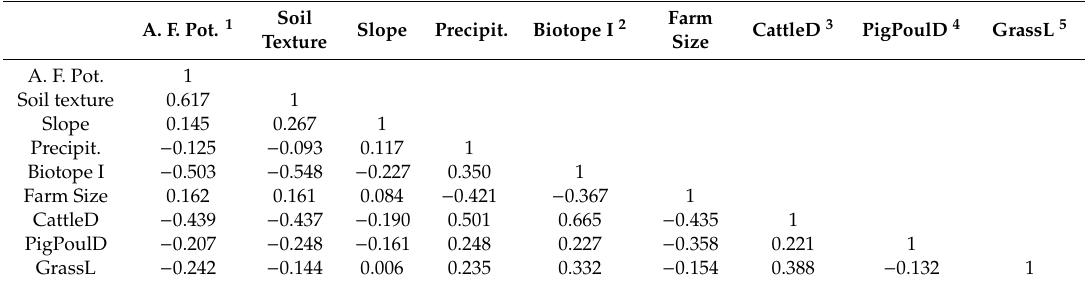
Table 2. Correlation matrix of the site variables used in the logistic regression